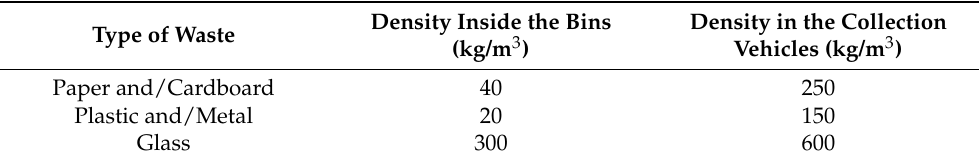
Table 5. Density of the materials collected by Valorsul inside the respective bins, and inside collection vehicles. Density Inside the Bins Density in the Collection Type of Waste (kg/m 3 ) Vehicles (kg/m 3 ) Paper and/Cardboard